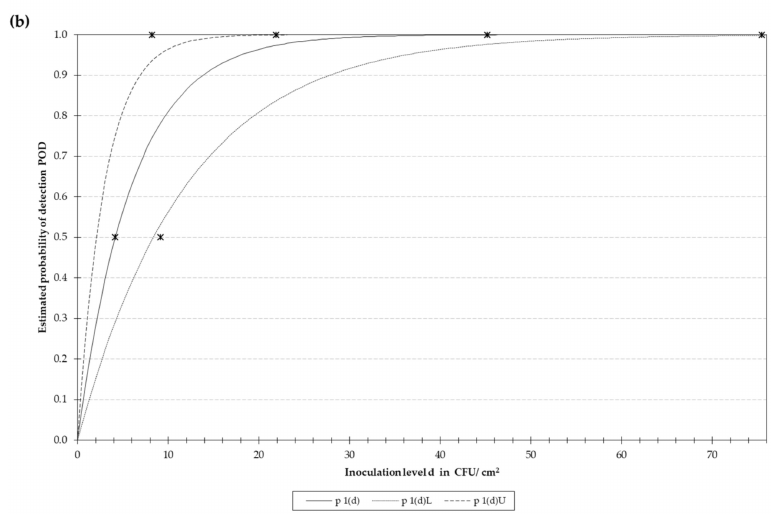
Figure 3. Optimization of sample pre-treatment. Two approaches for sampling were tested. ( a ) represents the estimated probability of detection (POD) using a swab and ( b ) using a sponge. “p 1(d)” represents the POD, “p 1(d)L” and “p 1(d)U” the Lower and Upper limit and the 95% confidence band, respectively, and the “*” indicate the actual values obtained for the samples analyzed included in the model. The results were obtained after a 24 h enrichment in ONE broth, and analysis with the primer set hly -RPA F / hly -RPA R. Note that in Figure 3a the lower limit does not reach the maximum as the X-axis was cut before 10 × 10 3 CFU / cm 2 for a more clear visualization of the results, the missing sample was inoculated with a concentration of 75 × 10 3 CFU / cm 2 .